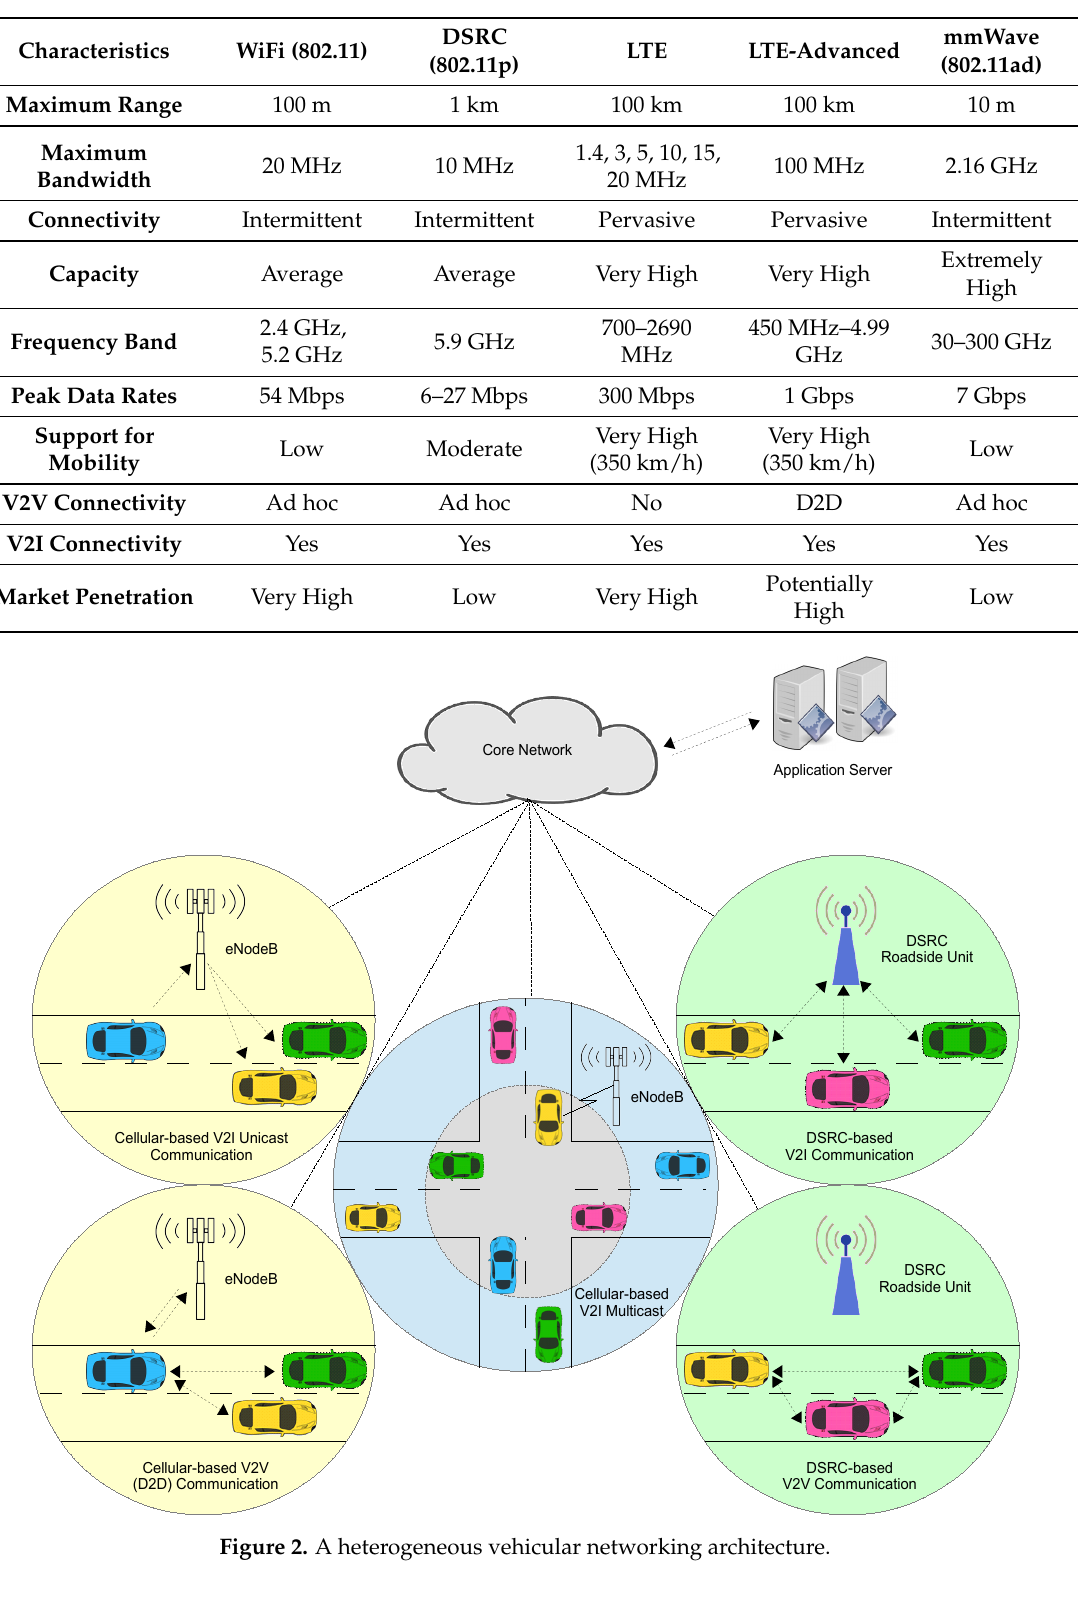
Table 1. Potential wireless technological candidates for vehicular communication.